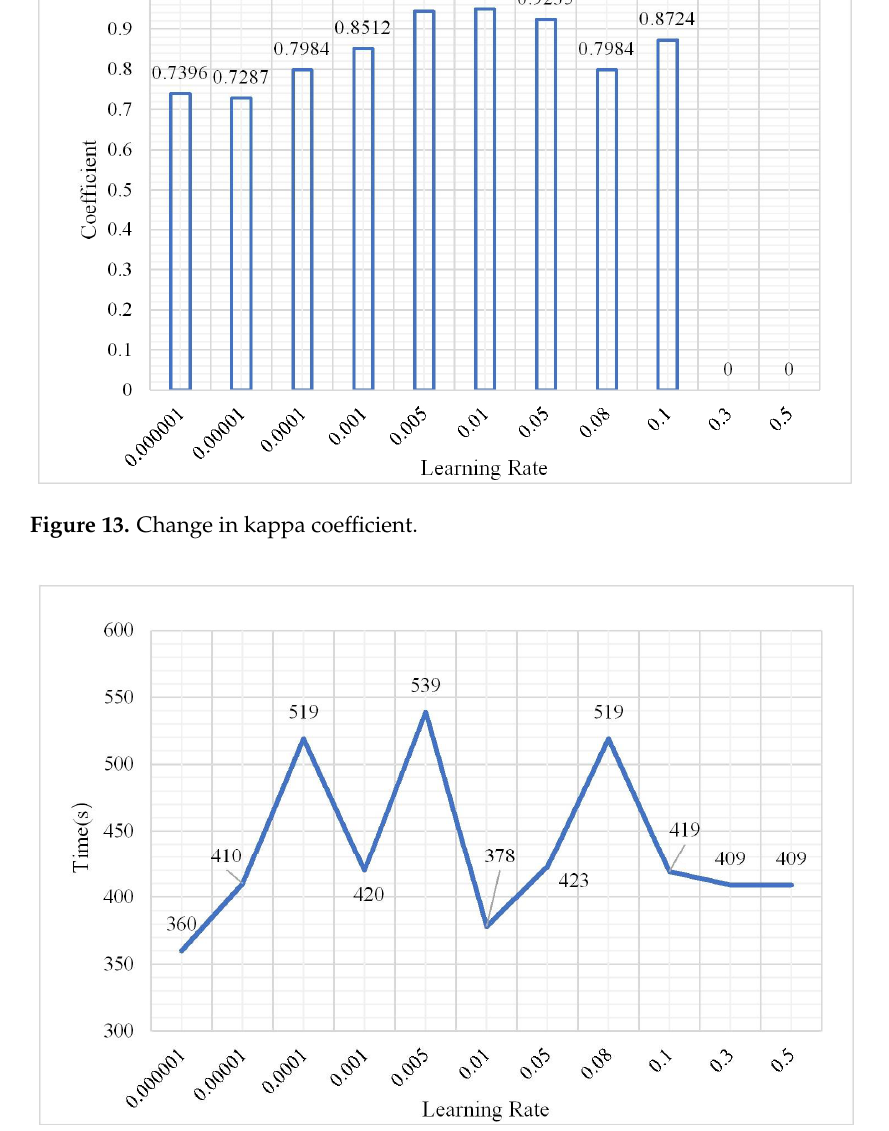
Figure 14. Change in training time.